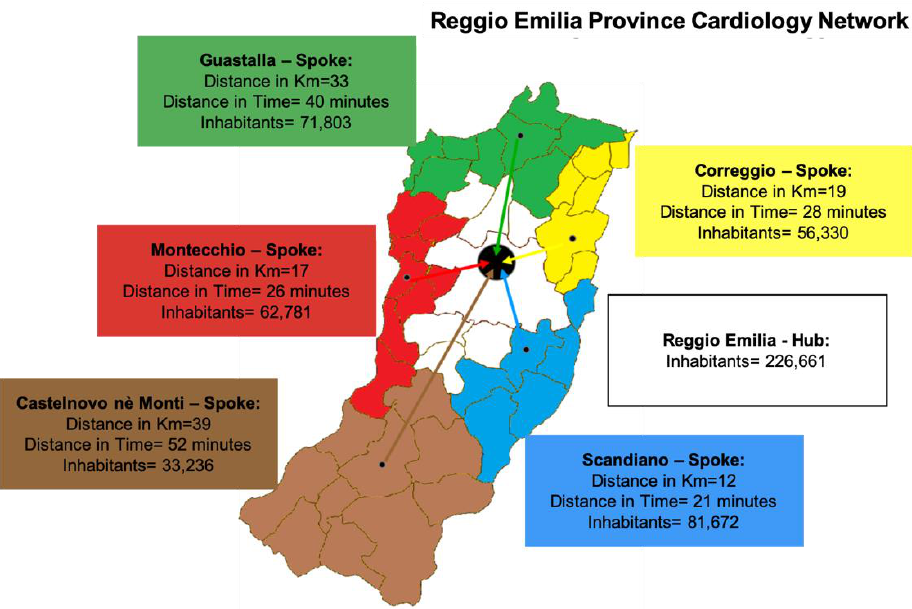
Figure 1. The cardiology network in Reggio Emilia. Six hospitals serve the Province of Reggio Emilia. Hospitals are organized according to their facilities: one invasive hub hospital with catheterisa- tion laboratory (cath-lab) with 24/7 service (Reggio Emilia) and five non-invasive spoke hospitals (Guastalla and Castelnovo nè Monti, whose data are the object of the present study and Correggio, Scandiano, Montecchio). The distance between the spokes and the hub centres are expressed in km and time.